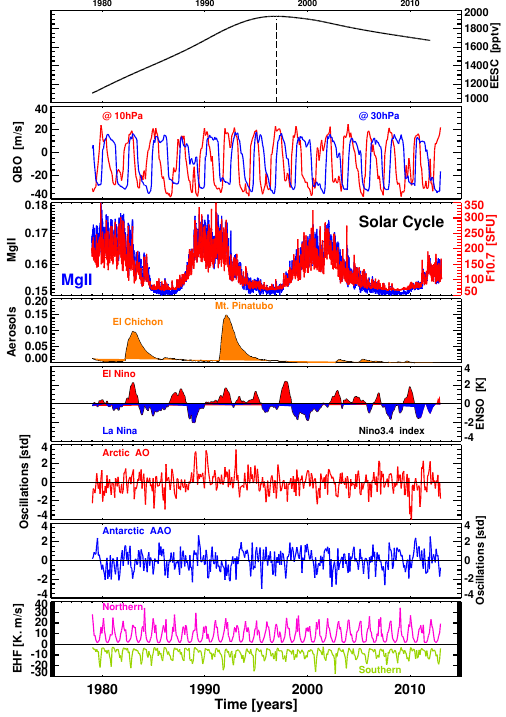
Figure 1. Time series of the different explanatory variables used in this study are displayed: stratospheric loading of ODSs (first panel) in terms of equivalent effective stratospheric chlorine (EESC) in pptv. Quasi-biennial oscillation (QBO) indices at 10hPa (red) and at 30hPa (blue) are shown in the second panel. The third panel displays the 11-year solar cycle as expressed by the solar flux at 10.7cm (red) and core-to-wing ratio of the magnesium line MgII at 280nm (blue). Time series of mean optical thickness at 550nm (or- ange) to account for volcanic aerosol enhancements are presented in the fourth panel. Niño 3.4 Index describing the state of the El Niño/Southern Oscillation (ENSO) is shown in panel five: El Niño (red) and La Niña (blue). The next two panels show the telecon- nection patterns: Arctic oscillation (AO) index in red and Antarc- tic oscillation (AAO) index in blue. In the last panel, extratropical eddy heat flux (EHF) at 100hPa averaged over midlatitudes (area weighted between 45 ◦ N and 75 ◦ N) and averaged from October to March in the Northern Hemisphere (magenta) and from March to September in the Southern Hemisphere